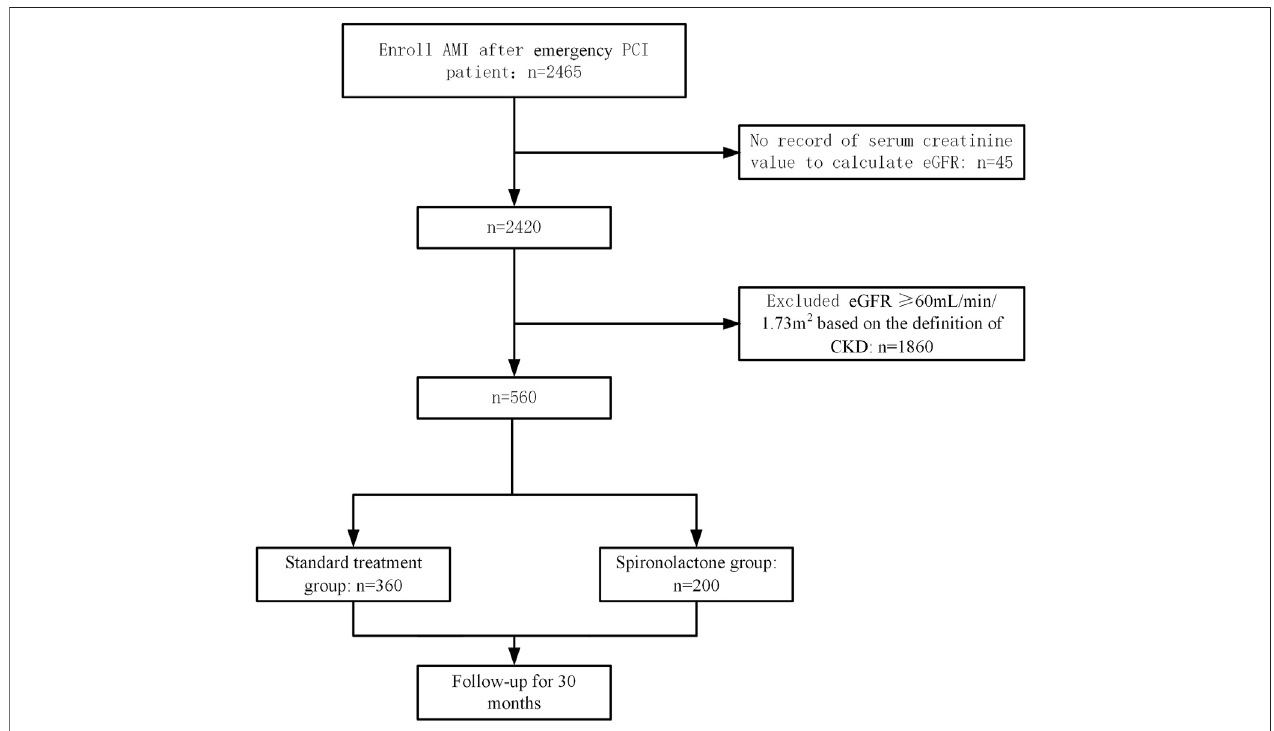
FIGURE1| Patientenrollmentandfollow-up fl owdiagram.AMI,acutemyocardialinfarction;PCI,percutaneouscoronaryintervention;eGFR,estimatedglomerular fi ltration rate; CKD, chronic kidney disease.